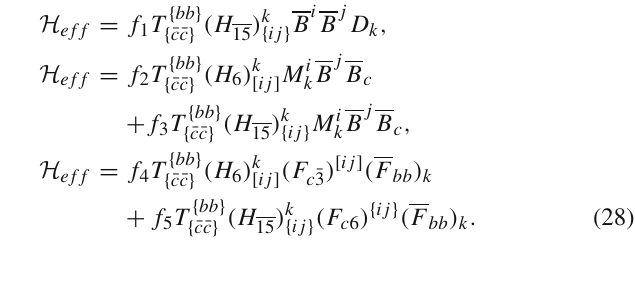
{ bb } Table 9 Tetraquark T Channel Amplitude {¯ c ¯ c } decays into doubly charmed baryon plus singly bottom baryon induced by the charmless b → s transition